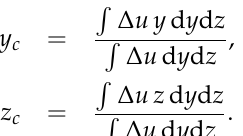
(cid:113) < M (cid:48)(cid:48) 2 > / ρ d ¯ u 2 = , ( b ) σ ∗ and ( c ) σ ∗ θ M , shear h h